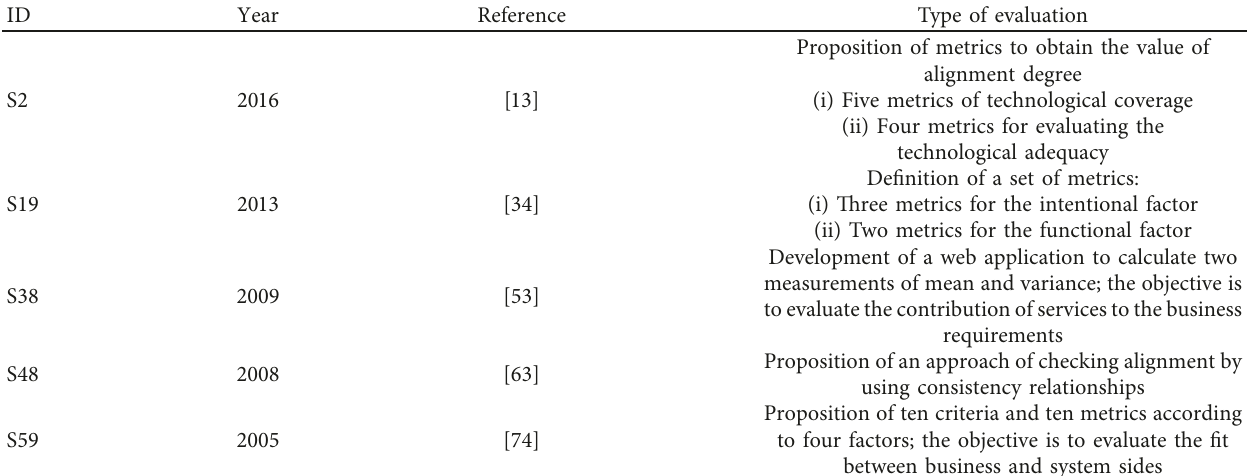
Table 5: Synthesis of methods used to evaluate